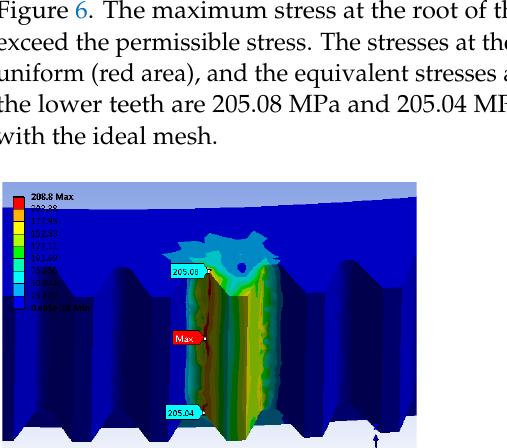
Figure 5. Meshing results.